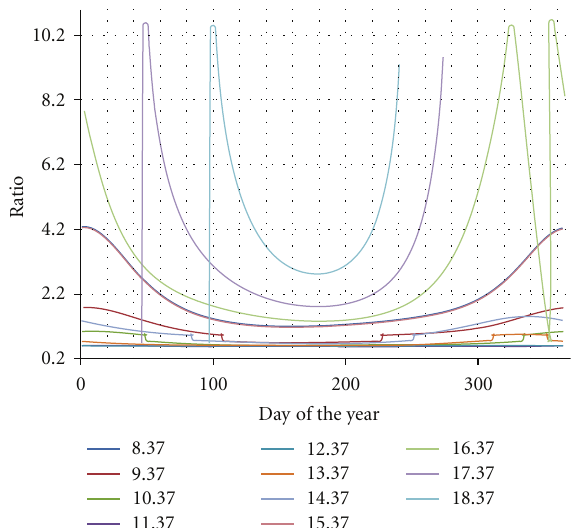
Figure 19: Ratio of mirror 3 along the year (shadows are consid- ered).